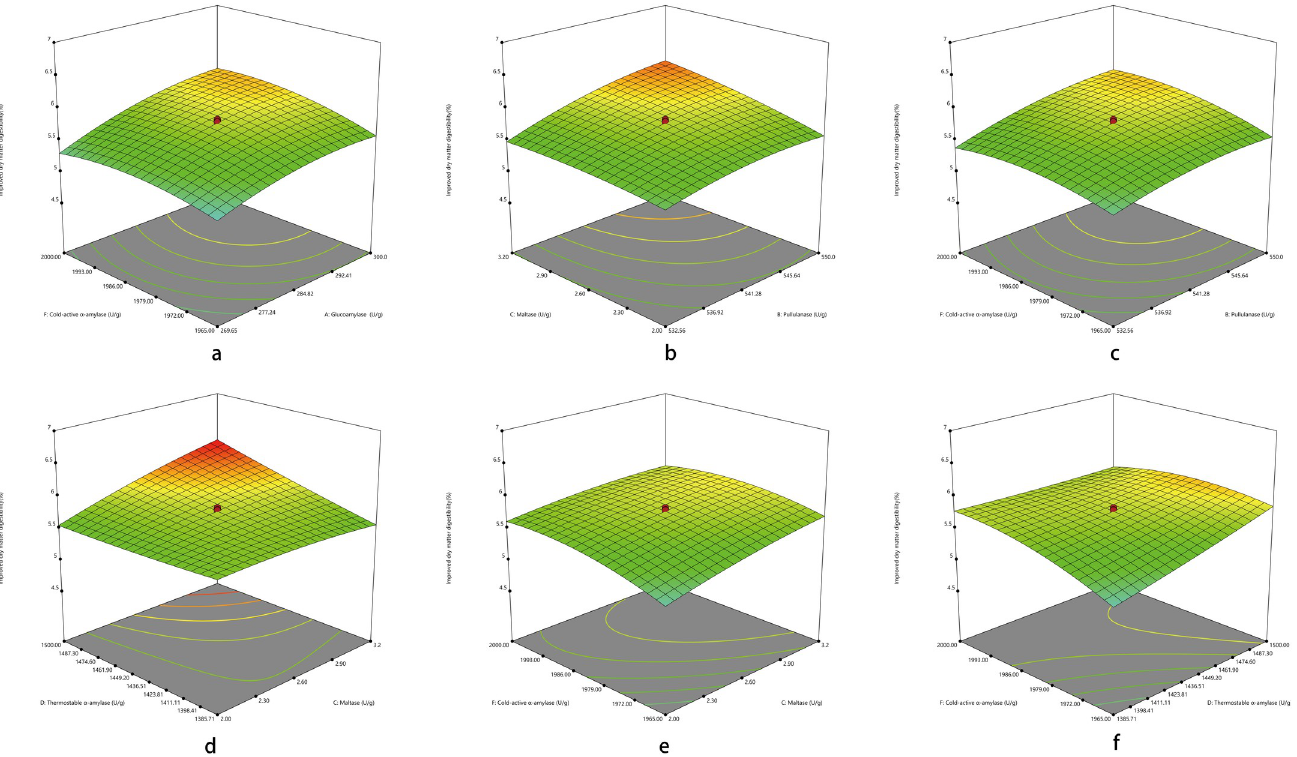
Fig 2. Respond surface plots for the significant interactions of exogenous carborhydrases on the improved DMD in diets for broilers aged 1 to 3 wk. (a) to (f) representing interactions of AF, BC, BF, CD, CF, and DF, respectively.